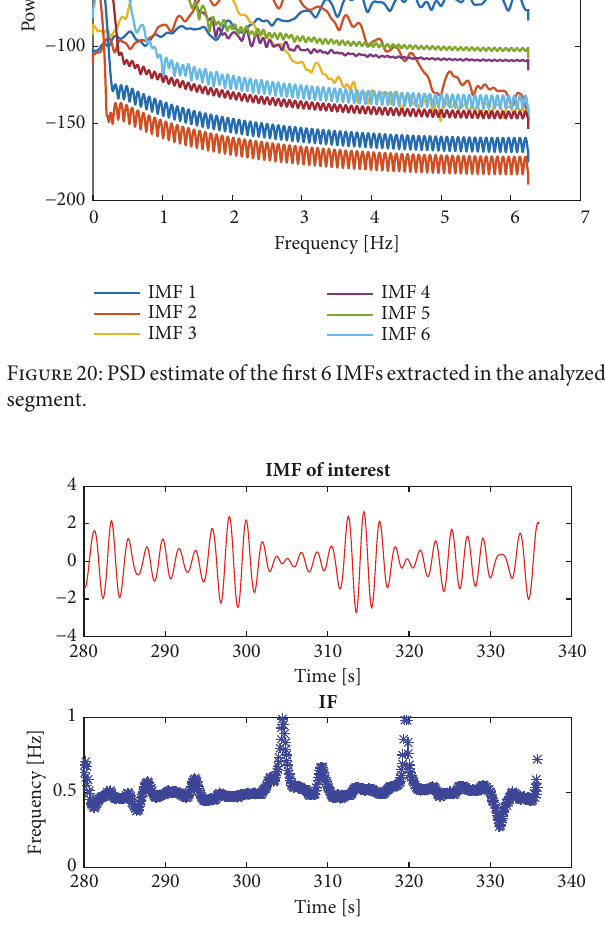
Figure 21: IMF 5 linked to BWR instability and its associated IF (oscillating close to 0.5